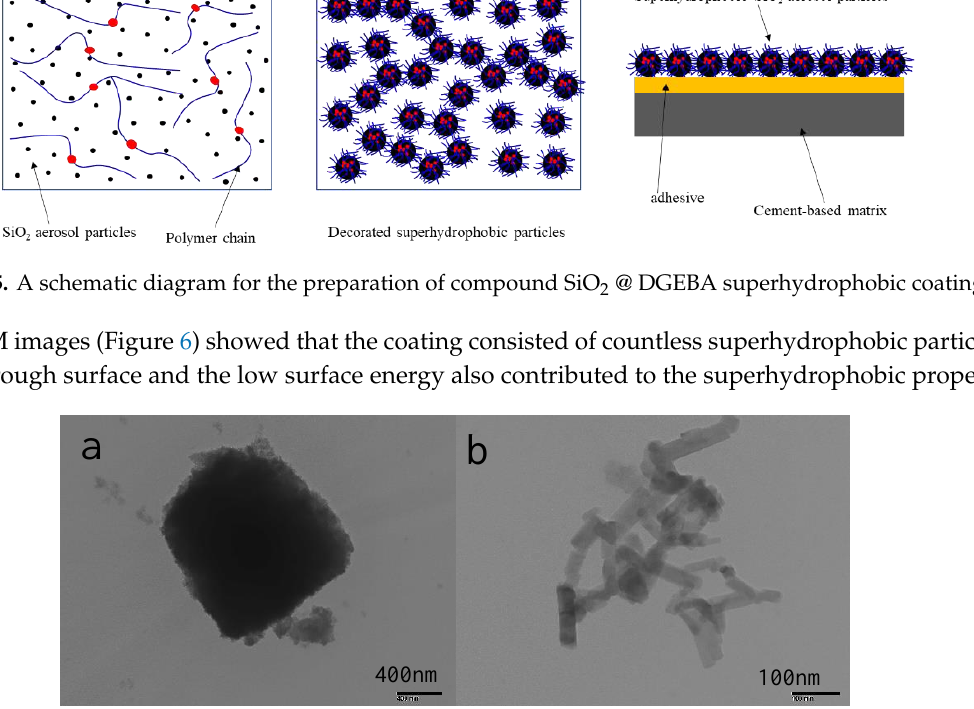
Figure 6. ( a ) Superhydrophobic particles with a rough surface; ( b ) The chain-type superhydrophobic particles.